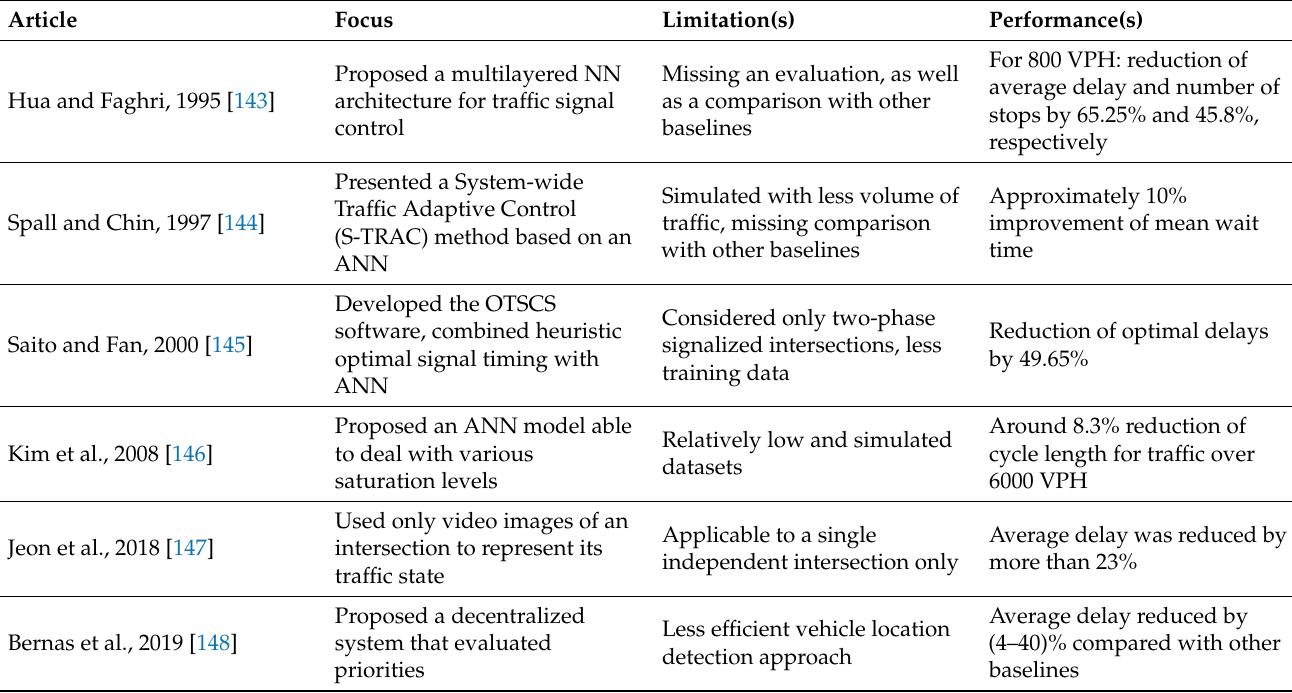
Table 24. Summary of the works found using